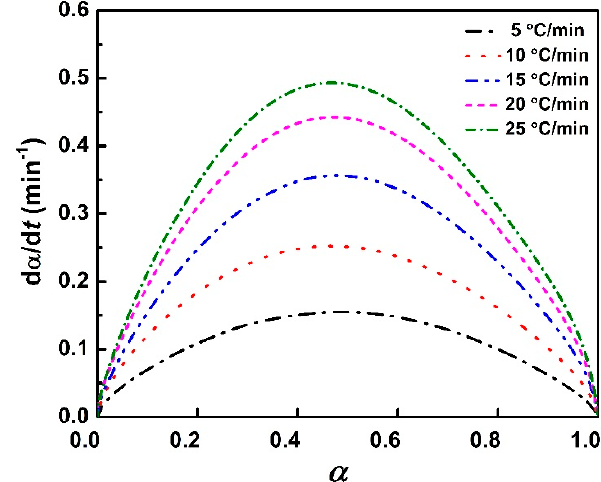
Figure 6. Reaction rate vs conversion plot at different heating rates.